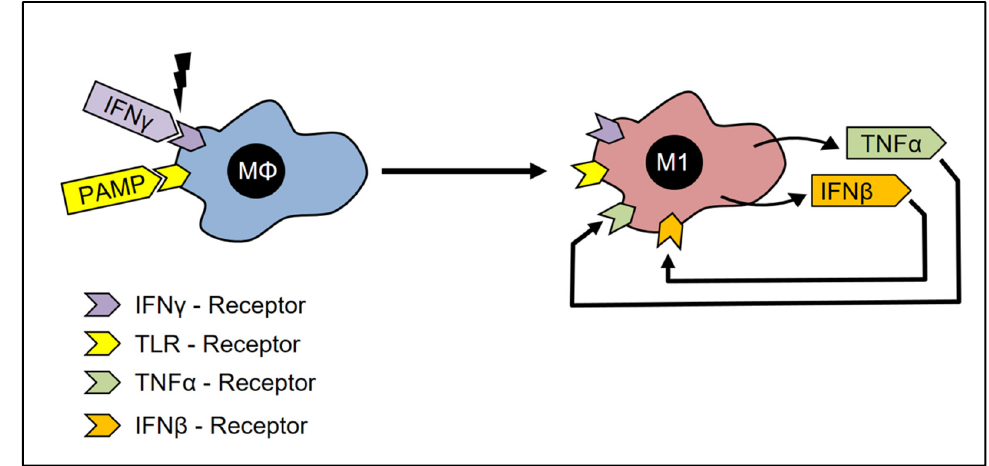
Figure 3. Activation of classically activated macrophages. In the presence of INF- γ -receptor ligands or PAMP, the macrophages adopt the M1 phenotype, which is characterized by the expression of INF- β and TNF- α –receptors. Furthermore, these cells are now capable of synthesizing TNF- α and INF- β and thus achieving